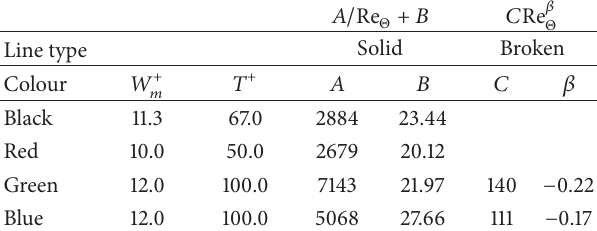
Table 3: Parameters for the profiles presented in Figure